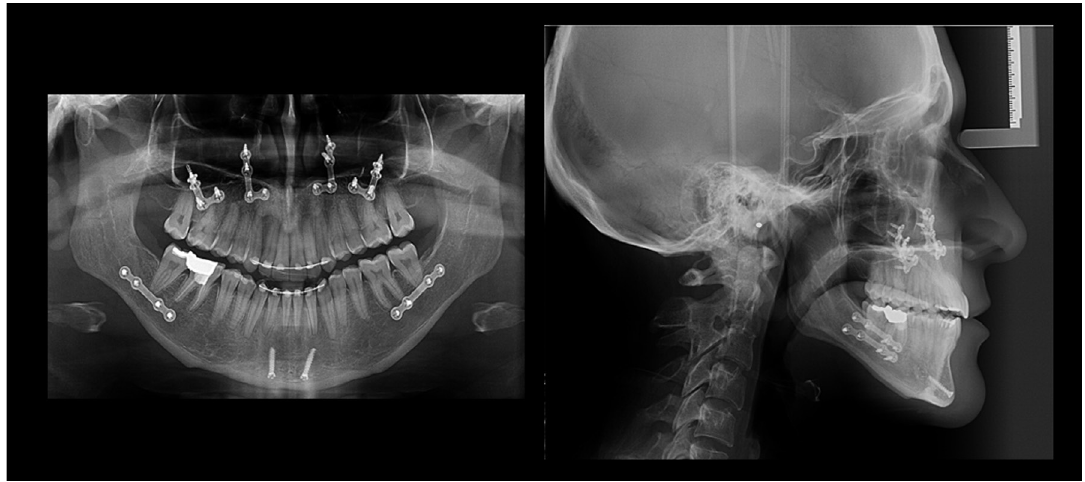
Figure 10. Post-treatment panoramic and lateral cephalometric